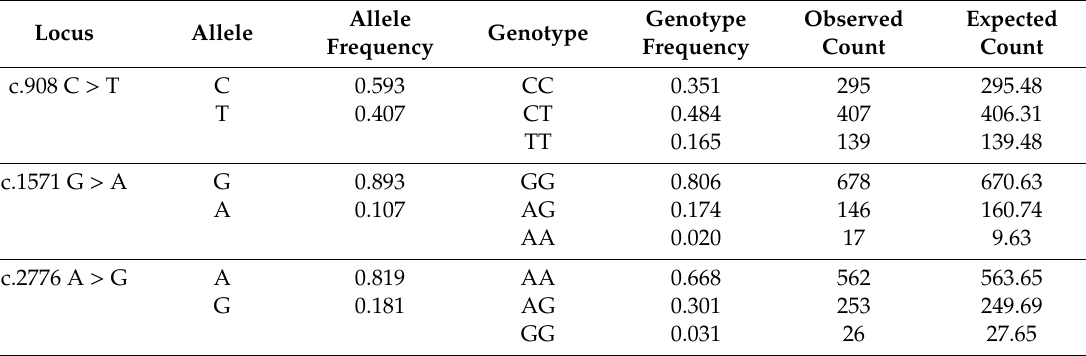
Table 1. The allele and genotype frequencies, and Hardy–Weinberg equilibrium test for the SNPs in the fatty acid desaturase 2 gene in Chinese Holstein cows.